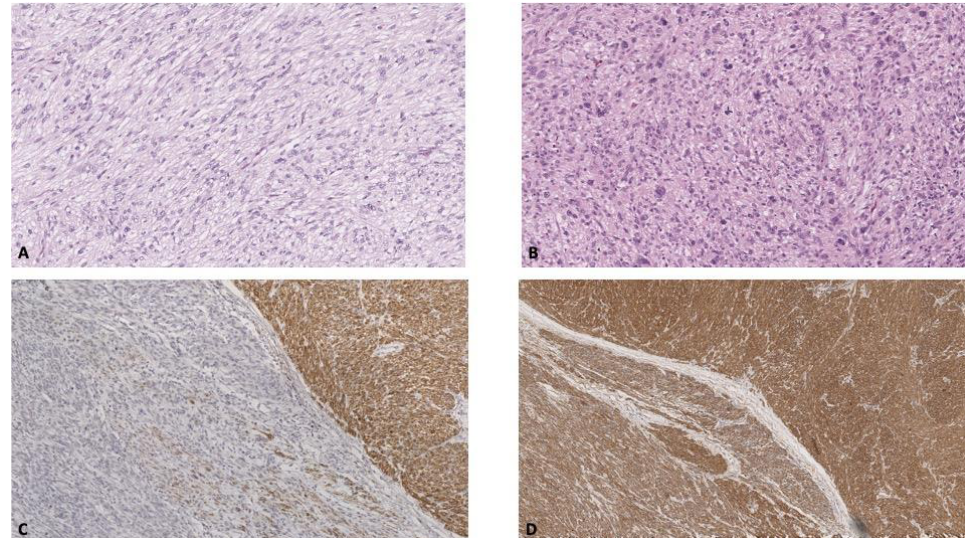
Figure 4. Histologic examination showed alternating areas of ( A ) bland spindle-shaped cells devoid of atypia and higher-grade foci ( B ) characterized by prominent nuclear pleomorphism and atypical mitosis. Desmin immunoperoxidase stain was irregularly conserved across the tumor, mostly lost on higher grade areas ( C ); on the contrary, smooth muscle actin staining was diffuse and intense ( D ). Neoplastic cells proliferative index (Clone MIB-1Agilent Technologies Inc., Santa Clara, CA, USA) was high, with hotspots in less differentiated areas of 55–60%. According to these parameters, a grade 2 primary mediastinal leiomyosarcoma diagnosis was